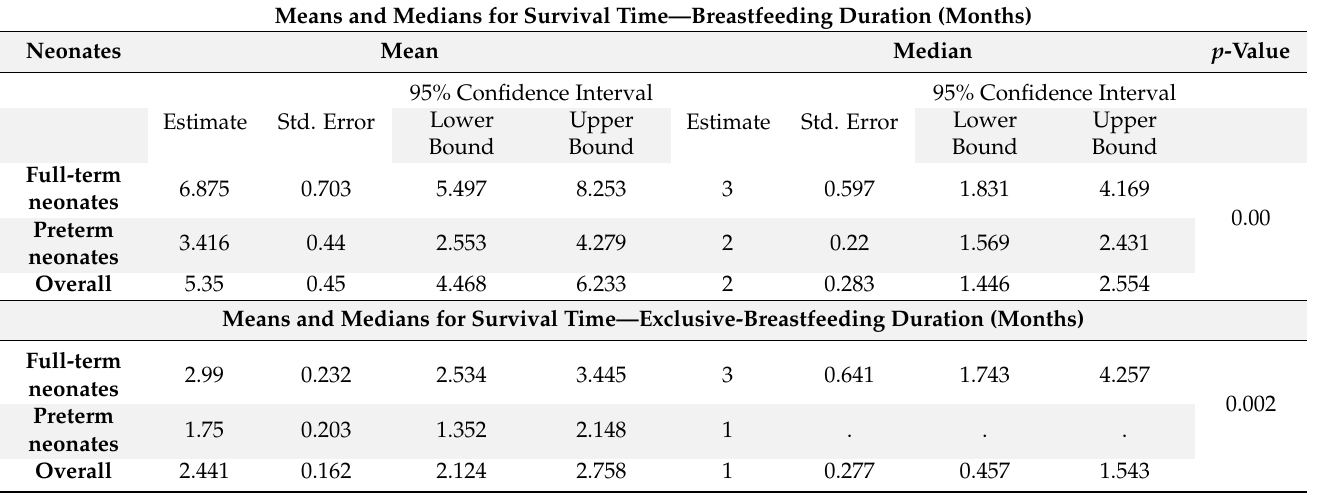
Table 3. Data on breastfeeding preterm and full-term neonates.